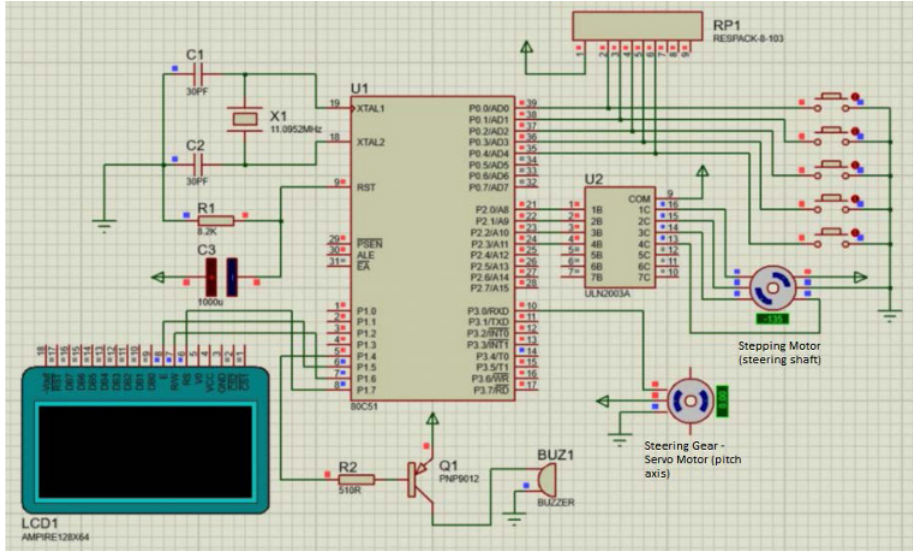
Fig. 2. Software simulation